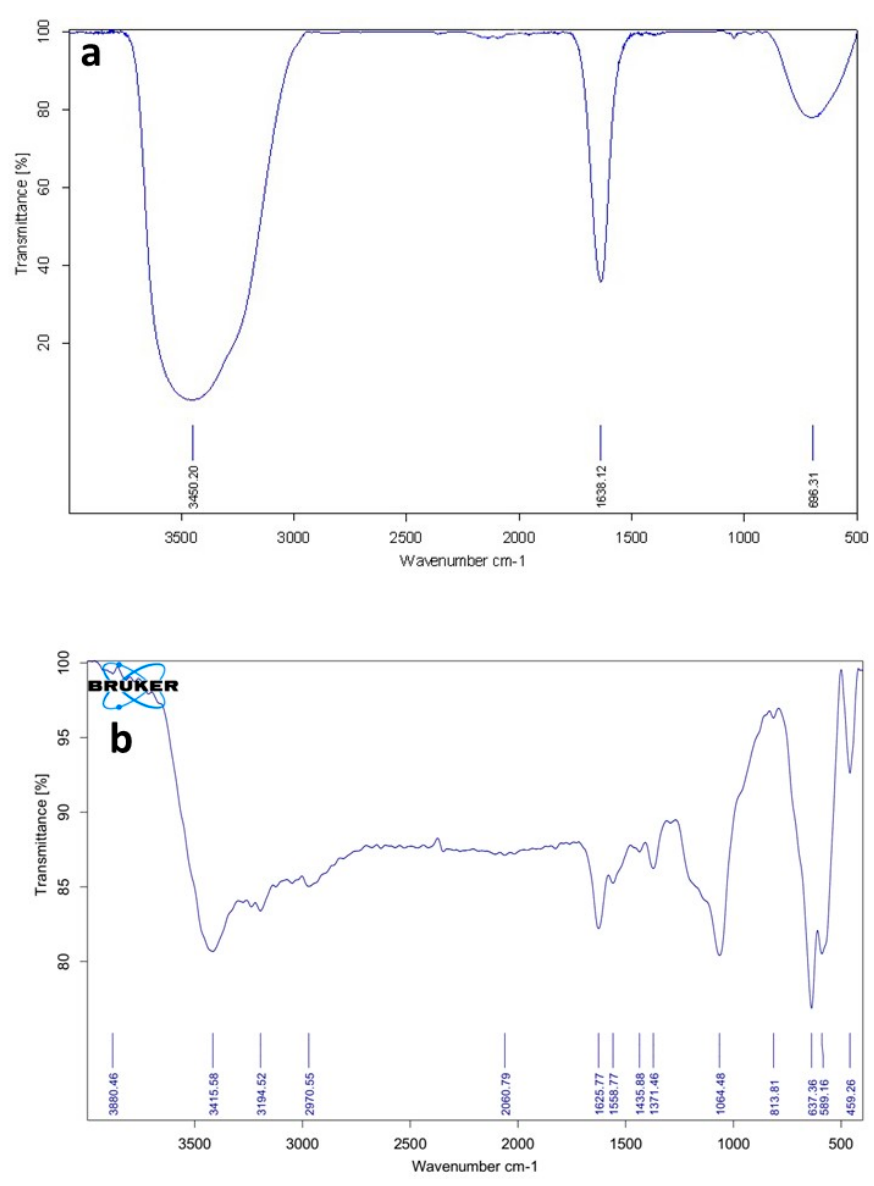
Figure 2. FTIR pattern of ( a ) Fe 3 O 4 nanoparticles and ( b ) NimMOF particles.